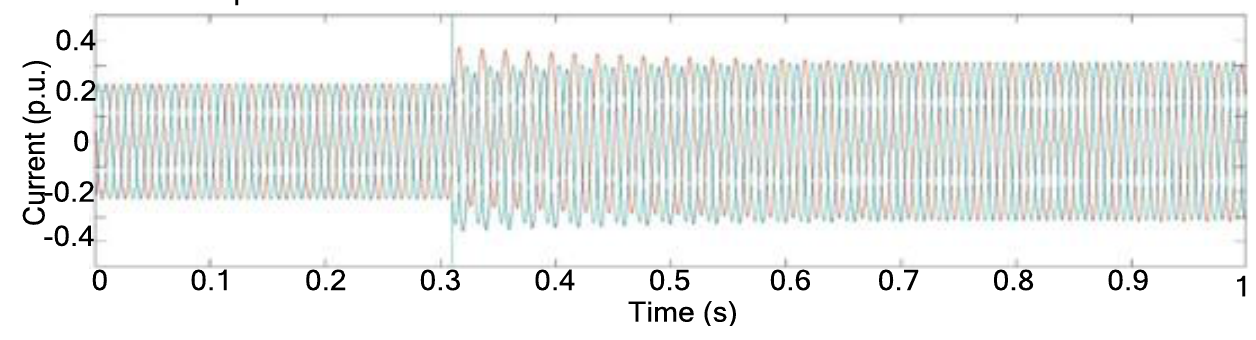
Figure 7. CASE 2 three-phase current waveforms at feeder “D” circuit breaker.